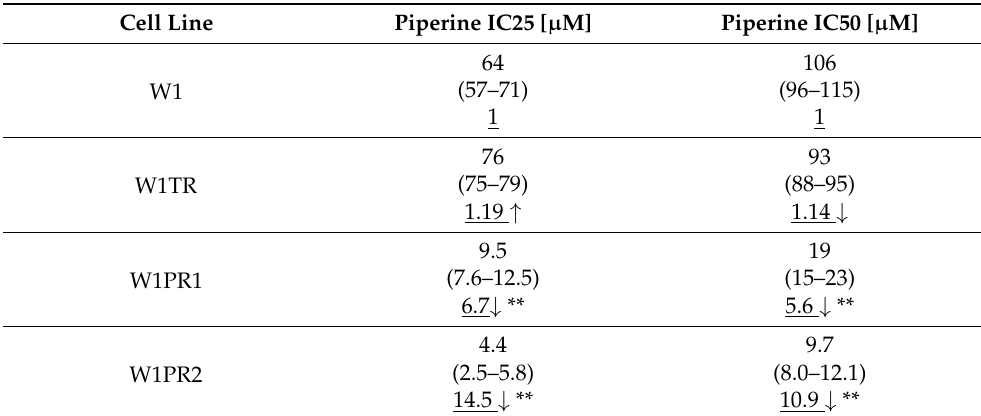
Figure 1. MTT cell survival assay for W1, W1TR, W1PR1, and W1PR2 cell lines treated with or without increasing piperine concentrations. The cell viability assay was expressed as a percent of untreated control (mean ± SEM). Table 1. Summary of cell lines resistance to piperine. ** p < 0.01.